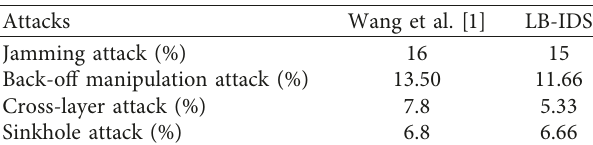
Figure 12: FNR comparison between LB-IDS and Wang et al. scheme [1]. Table 5: Average of false-negative rate.